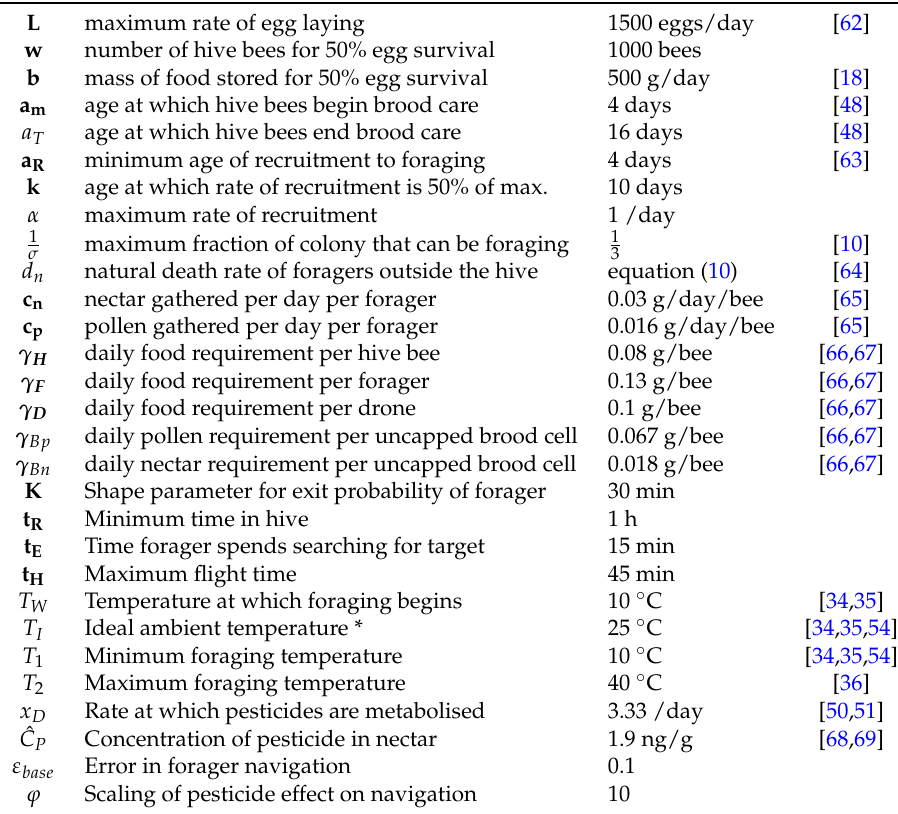
Table 1. Parameter values and source